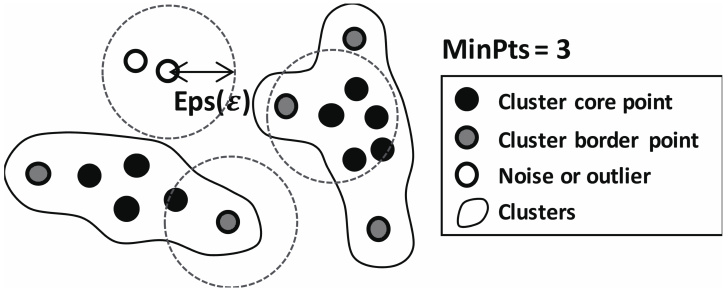
Figure 3. Density-based spatial clustering of applications with noise (DBSCAN)